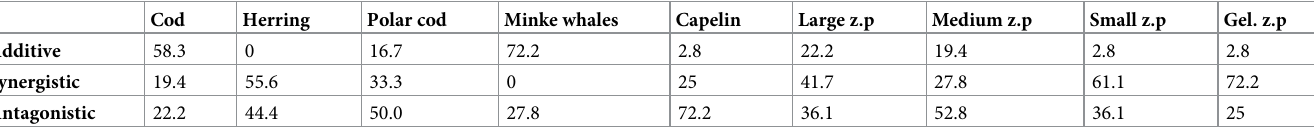
Table 6. Overview of additive/non-additive effects (in % of runs) on the key species in the 36 combination